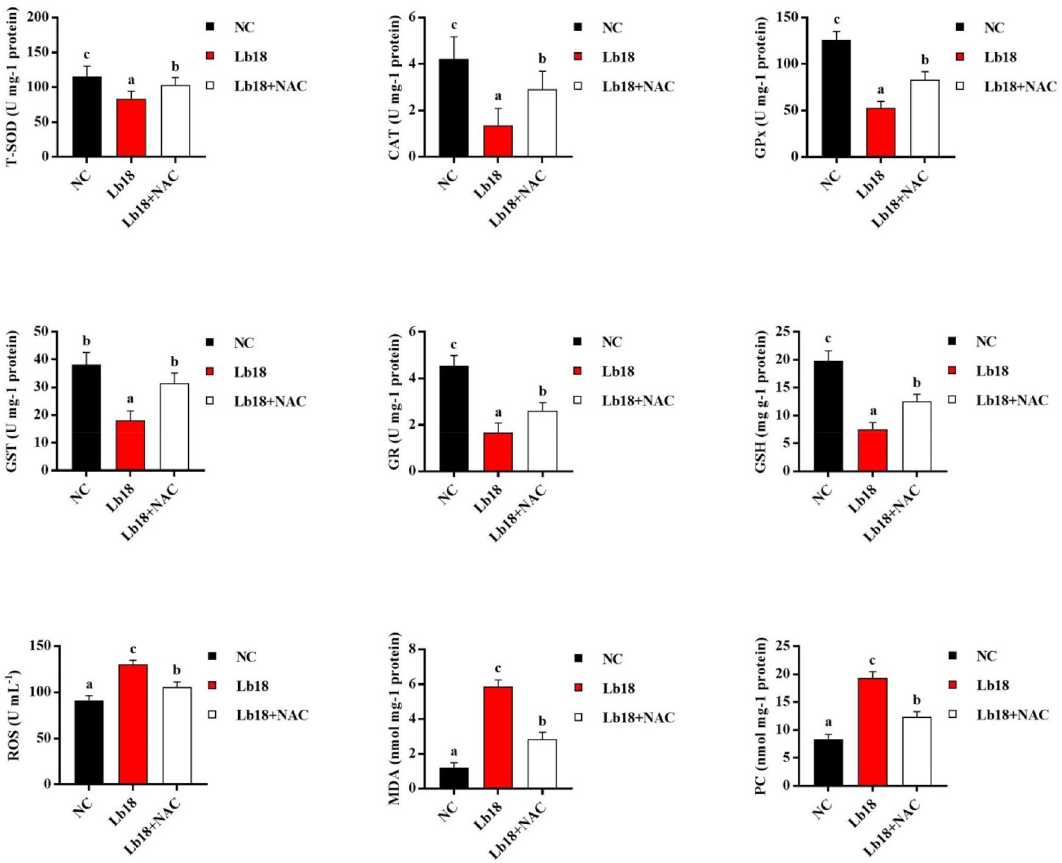
Figure 2. Effects of infection with P. vulgaris and E. meningoseptica on antioxidant system-associated indicators in the muscle of Chinese soft-shelled turtles. Values represent the mean ± S.E. (n = 3 replicate tanks), 3 turtles were sampled for each tank, the data with different letters show significant difference ( p < 0.05). T-SOD, total superoxide dismutase; CAT, catalase; GPx, glutathione peroxidase; GST, glutathione-S-transferase; GR,